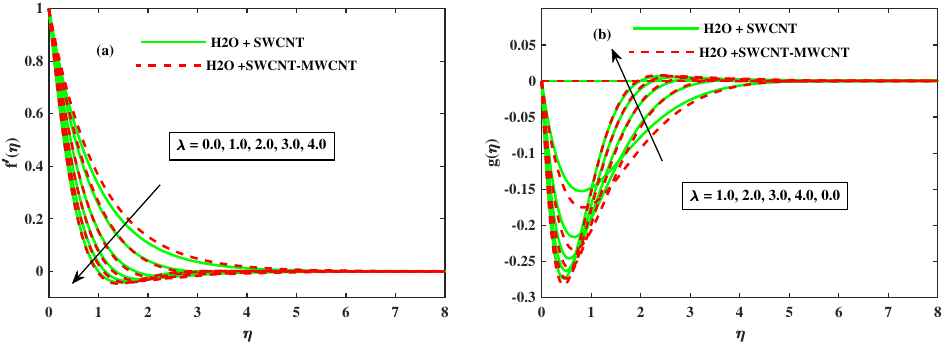
Figure 2. Effect of λ on velocity profile ( a ) along x -direction and ( b ) y -direction.